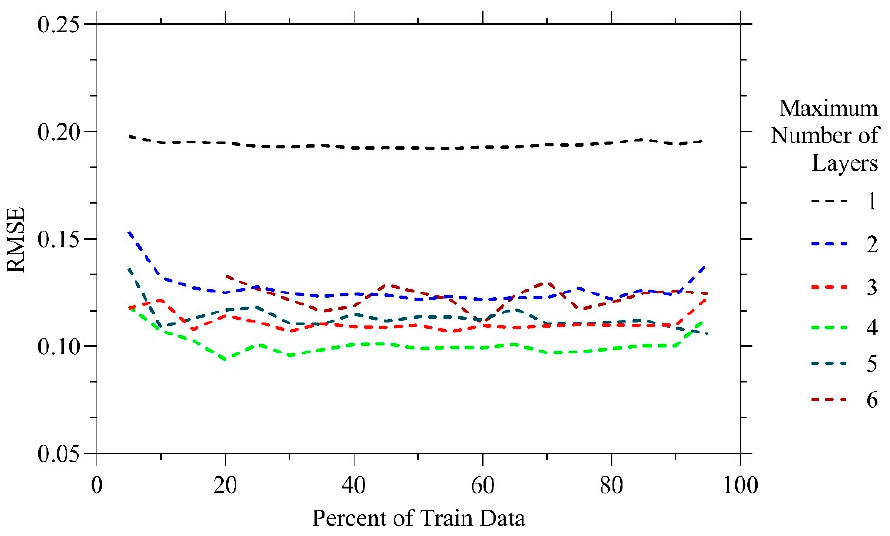
Figure 10. GMDH: dependence of the RMSE at the end of training on the maximum number of in the ANN, and on data layers in the ANN, and on data proportioning.